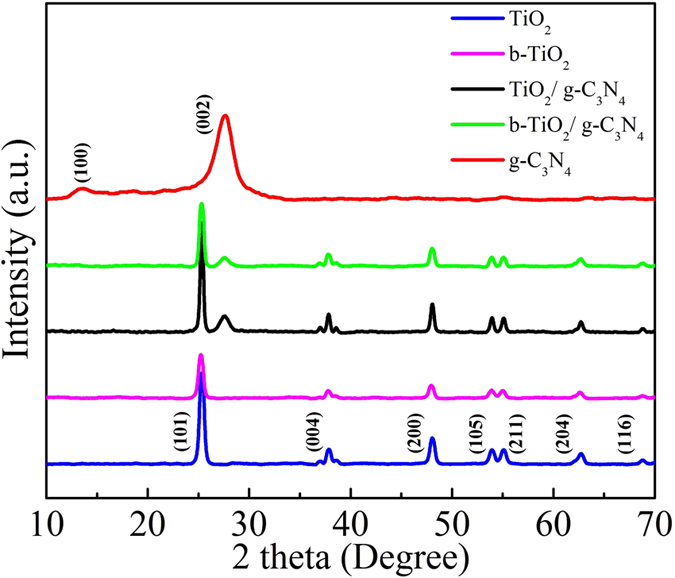
XRD patterns of TiO2, g-C3N4, b-TiO2, TiO2/g-C3N4, and b-TiO2/g-C3N4, respectively.